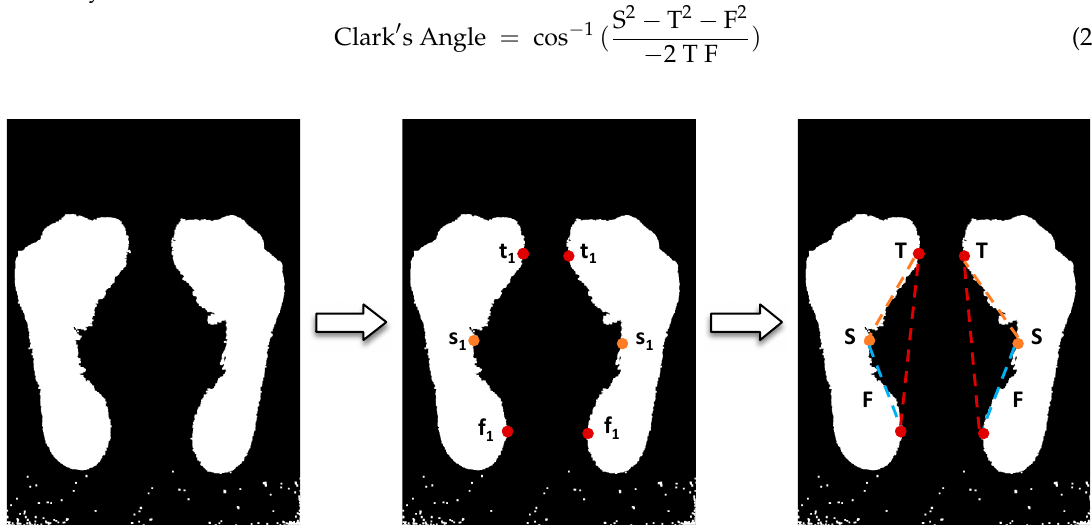
Figure 7. The process of Clarke’s angle estimation.